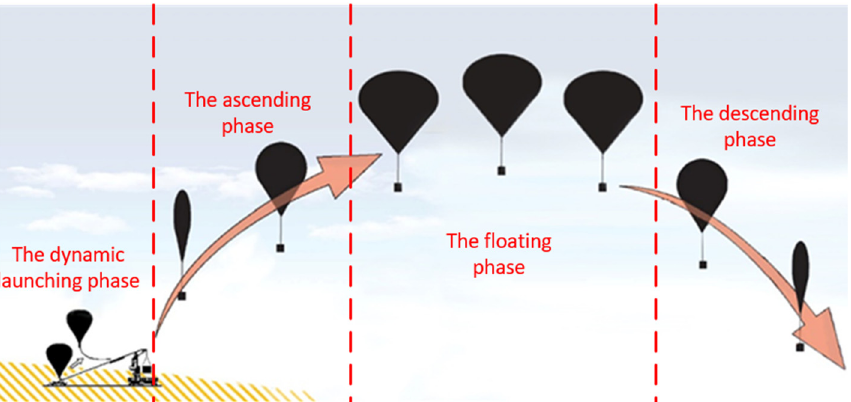
Figure 1. Flight mission of a balloon flight system.